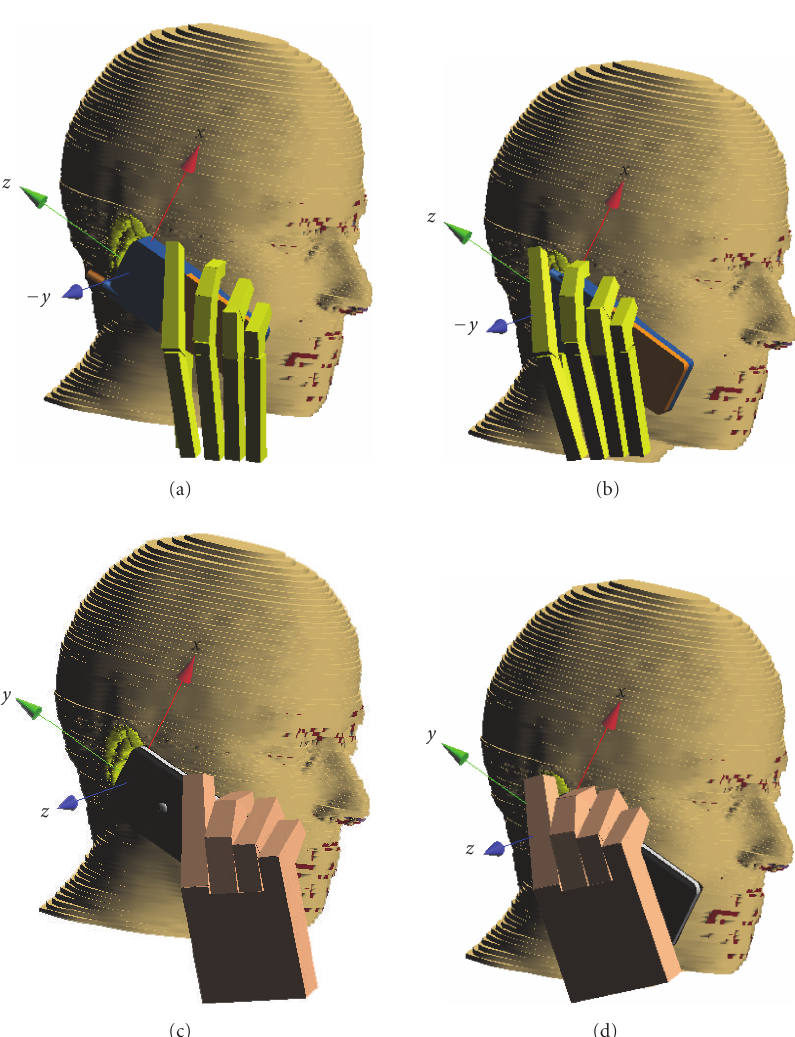
Figure 4: Di ff erent CAD representations of the handset in hand against HR-EFH at cheek position: (a) Model-A2 in hand1 (bone only), (b) Model-A1 in hand2 (bone only), (c) Model-B1 in hand1, and (d) Model-B1 in